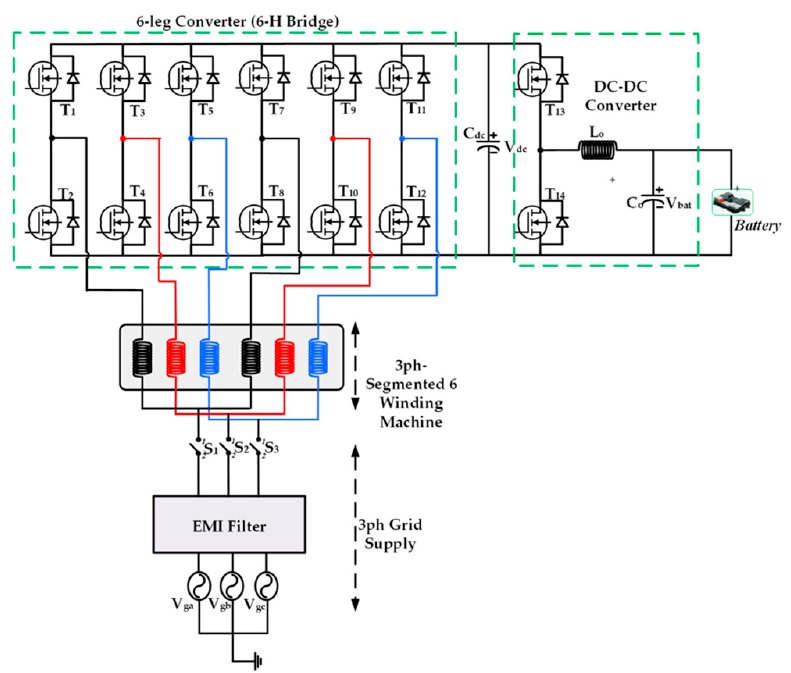
Figure 14. Integrated On − Board Charger based on 3-Phase 6-Segmented Winding Machine proposed by Han et al. [82] in 2018. (iOBC10).